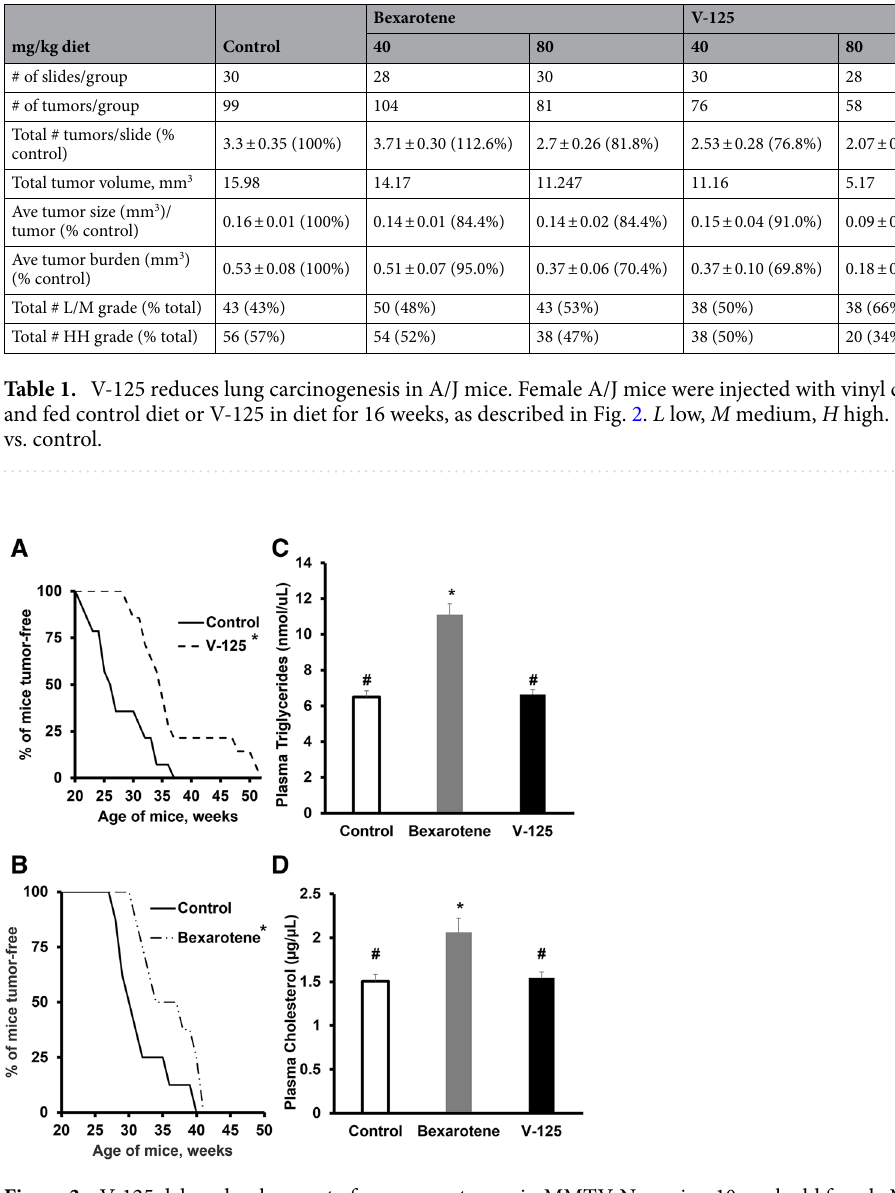
Figure 3. V-125 delays development of mammary tumor in MMTV-Neu mice. 10 week old female MMTV- Neu mice were fed control diet or 30 mg/kg diet of the rexinoids V-125 ( A ) or bexarotene ( B ). Mice were palpated twice weekly for the development of new tumors. ( A ) *P < 0.001 vs. control via log rank test; N = 14 mice per group. ( B ) *P < 0.05 vs. control via log rank test; N = 8–9 mice per group. Plasma triglycerides ( C ) and cholesterol ( D ) levels in mice treated with control or rexinoids (30 mg/kg diet) were quantified using commercial kits (*P < 0.01 vs. control; # P < 0.01 vs. bexarotene; n = 8